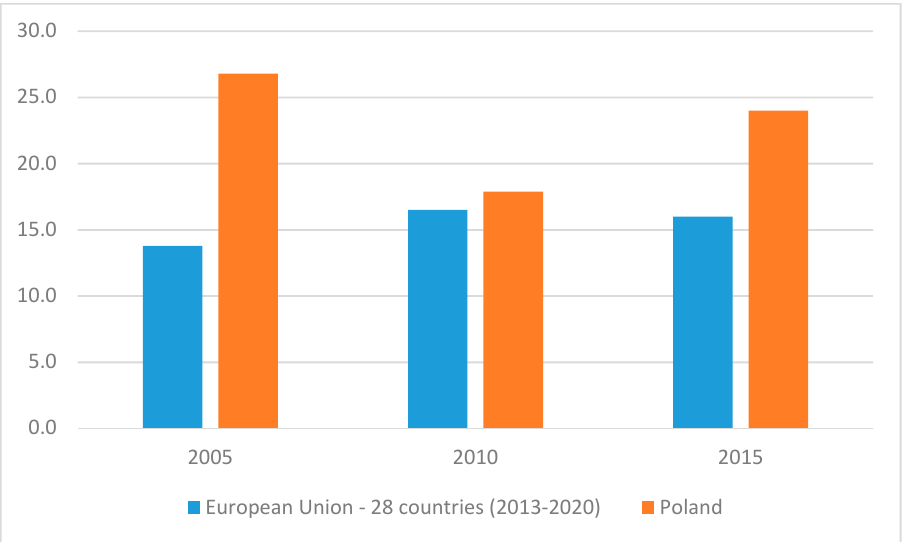
Figure 4. The employed expecting a possible job loss over the next 6 month (Eurostat 2015).